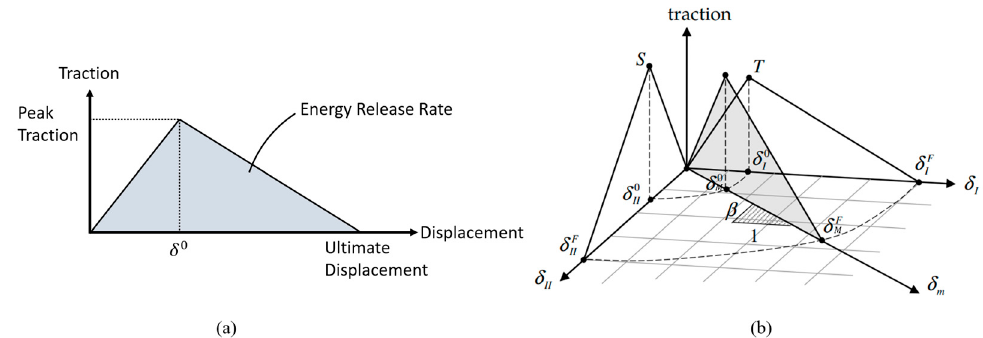
Figure 7. Bilinear CZM models: ( a ) the single-mode model; ( b ) the mixed-mode model [27]. Table 3. CZM tiebreak contact